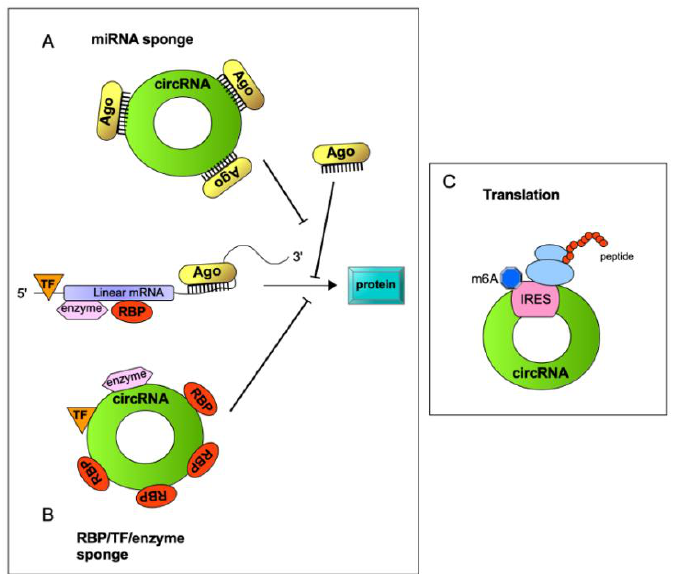
Figure 2. The biological functions of circRNAs. ( A ) circRNAs can function as a miRNA sponge to rescue target mRNA expression, thus inducing translation; ( B ) some circRNAs bind to RNA binding proteins (RBP), transcription factors (TF) or enzymes altering gene expression and cellular metabolism; ( C ) some circRNAs contain an open reading frame (ORF) and can be translated, pro- ducing peptides. UTRs including m6A modification, IRES, and/or IRES-like sequences may induce circRNA translation.